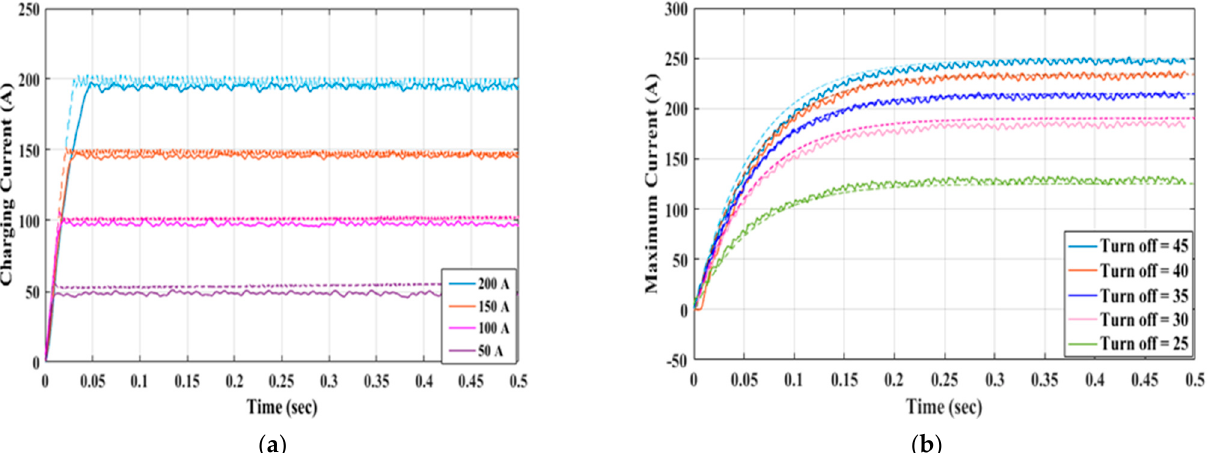
Figure 23. Opal-RT real-time simulator response for turn-on angle, ( a ) constant current response at different references currents, ( b ) effect of turn-off angle on maximum constant current (solid line is experimental, and dashed line is simulation).